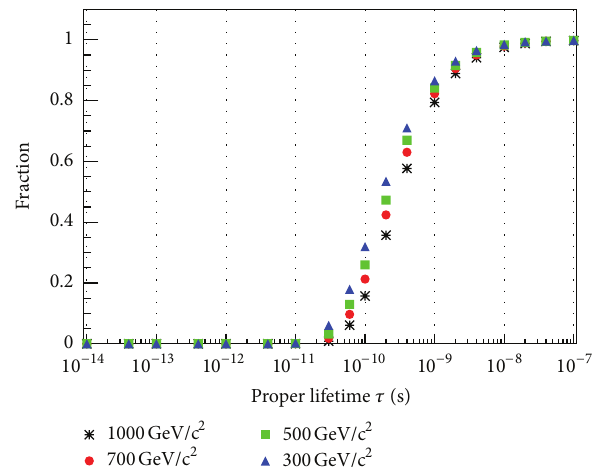
Figure 7: Fraction of rejected decays of heavy quarks outside of the geometrical acceptance of 4 cm around the primary interaction vertex as a function of the proper lifetime 𝜏